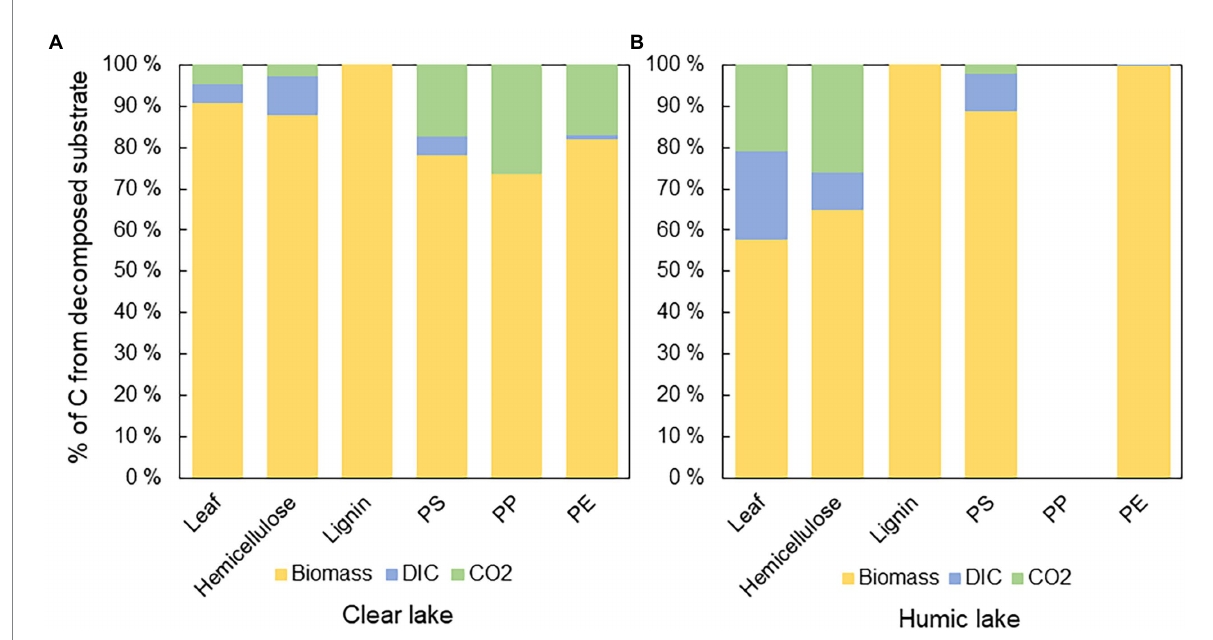
FIGURE 4 The fate of 13 carbon from different substrates in (A) clear and (B) humic lake water. The major fate of 13 C was in microbial biomass except in humic lake water with PP addition, where decomposition was not detected. In humic lake water n = 4 for leaf, PS, PP, and PE treatments and n = 3 for lignin and hemicellulose. In clear lake water n = 4 for lignin, hemicellulose, and PS treatments and n = 3 for leaf, PP, and PE.